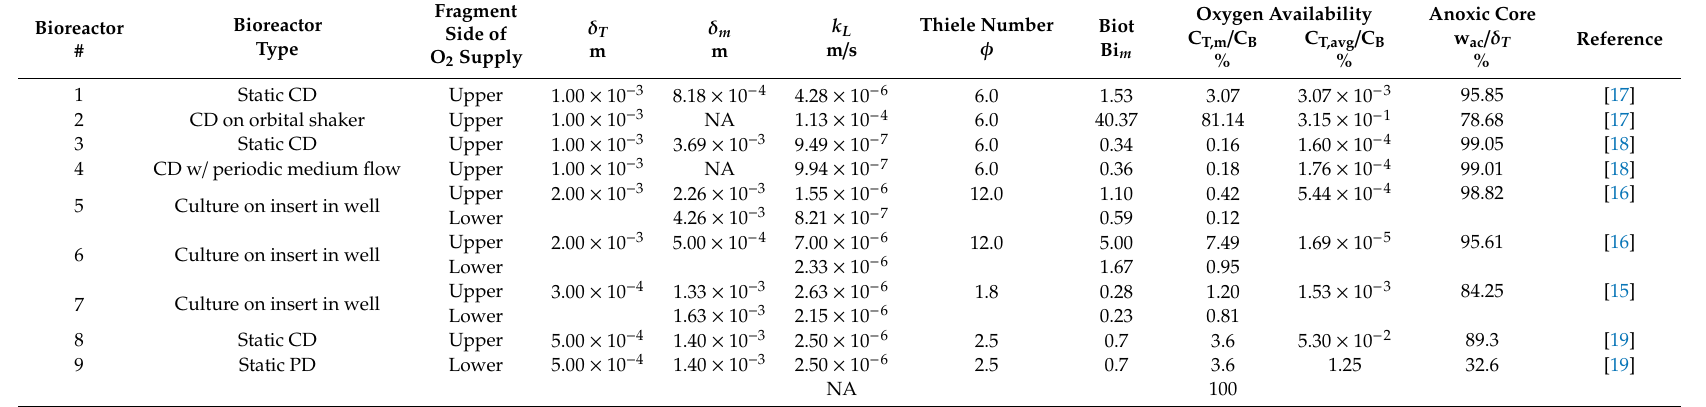
Table 2. Model-predicted oxygen availability, CT, avg, width of anoxic zone, wac, and O 2 concentration at tissue medium interface, CT, m, for the bioreactor geometry and fluid dynamic conditions used in the literature reports analyzed in this study. Other symbols are defined in the